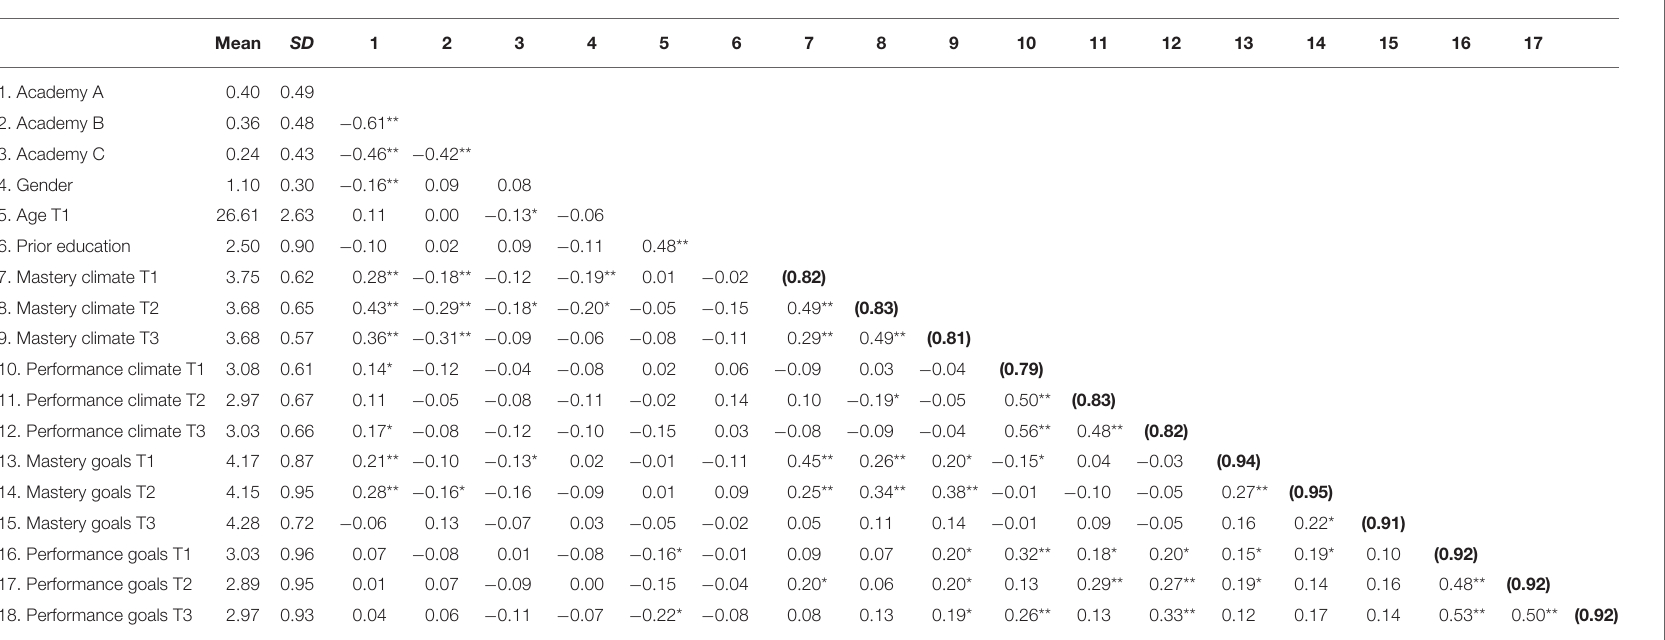
TABLE 1 | Descriptive statistics, scale reliabilities, and